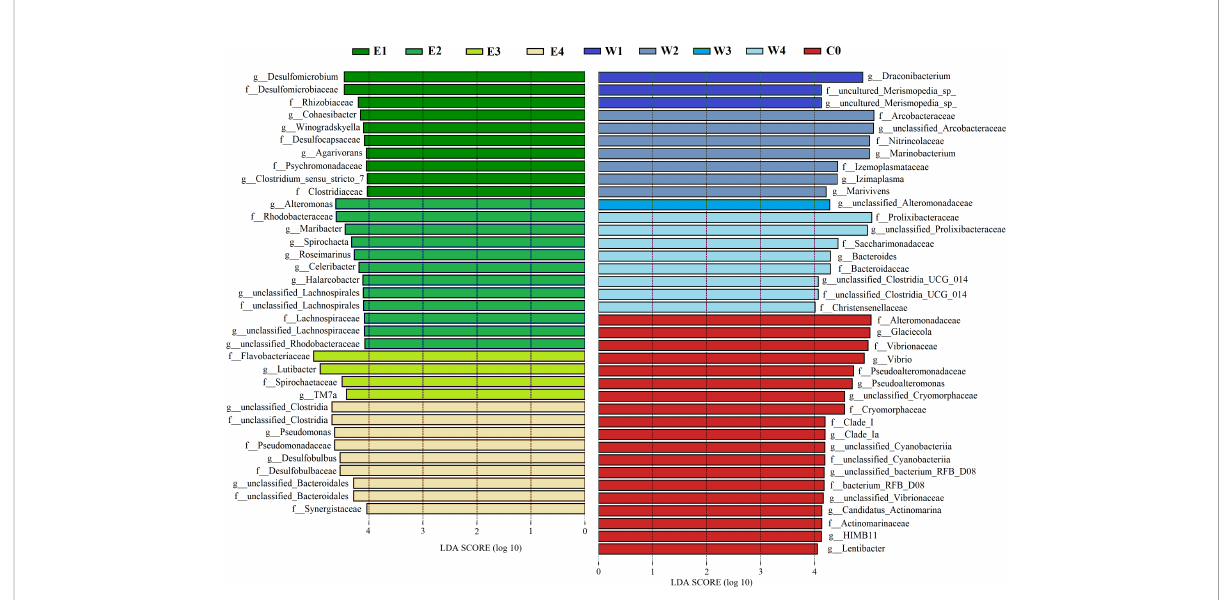
FIGURE 6 Histogram of the LDA scores computed for differentially abundant taxa on family and genus levels across all sample groups. E and W refer to the epiphytic and phycospheric seawater bacterial sample groups, respectively. The numbers 1 to 4 refer to the P1 to P4 phases, respectively. C0 refers to the control seawater bacterial sample